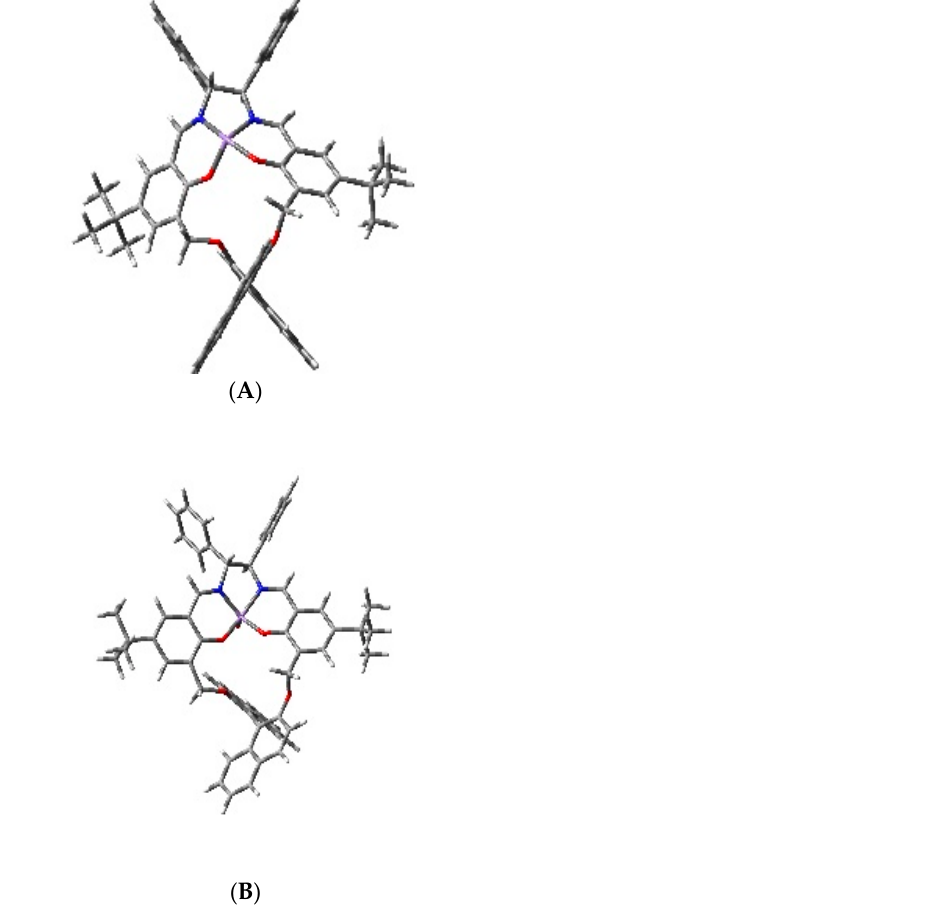
Figure 3. 3D-plots of Mn-M20 ( A ) and the corresponding activated structure ( B ) minimized at the b3lyp/def2svp level for Mn and b3lyp/6-31 g(d) for all other atoms.